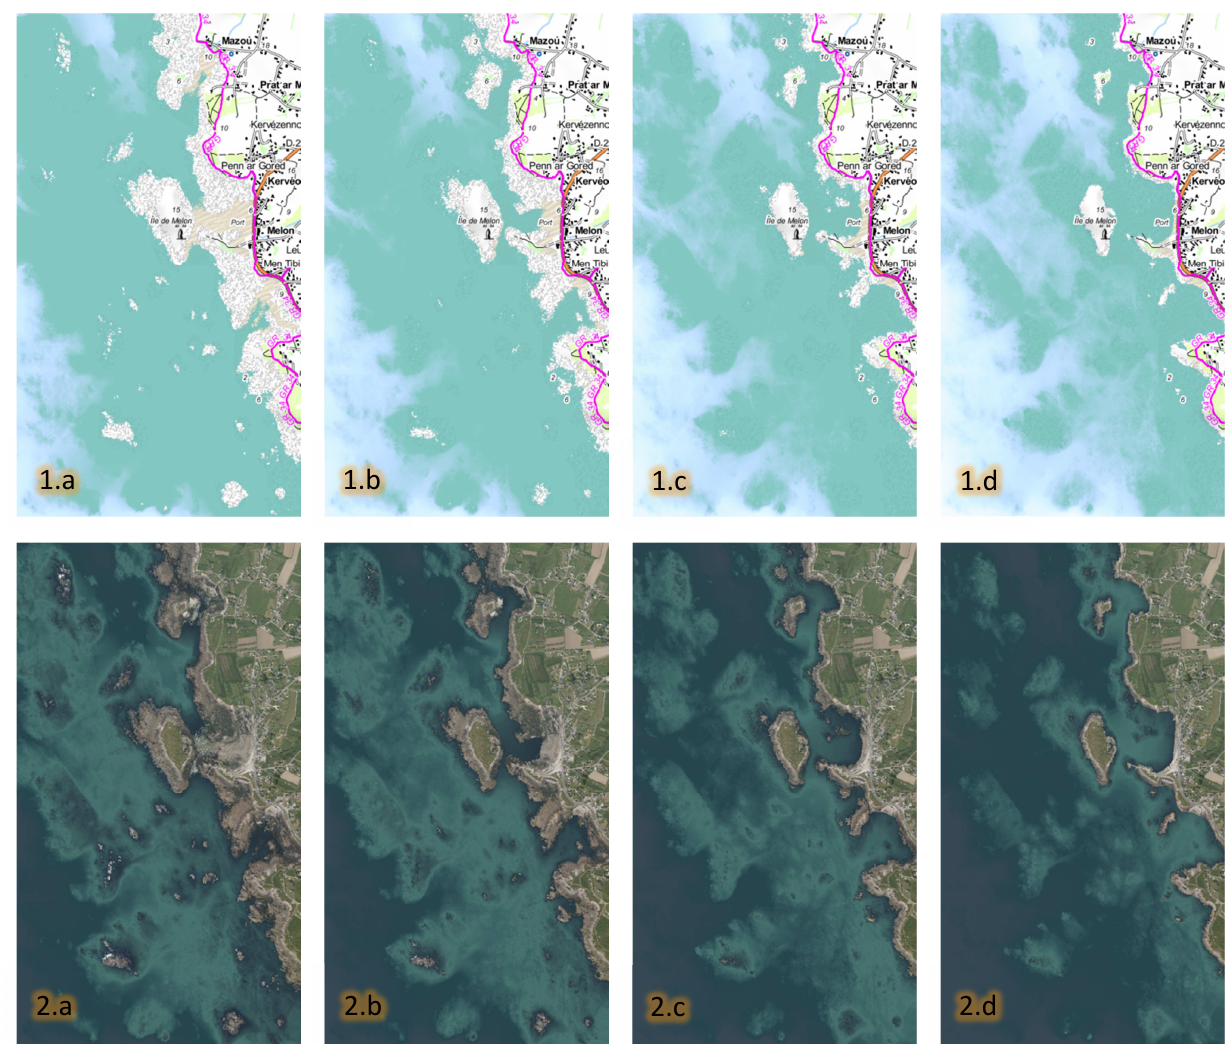
Figure 8. Evolution of the sea/land interface and the water depth at different water elevations/time of the day 05/28/2009 (see Figure 3) for application (1) and (2): (a) 1.4 meters, 14h00 (b) 3 meters, 15h30 (c) 5 meters, 16h45 and (d) 7 meters,